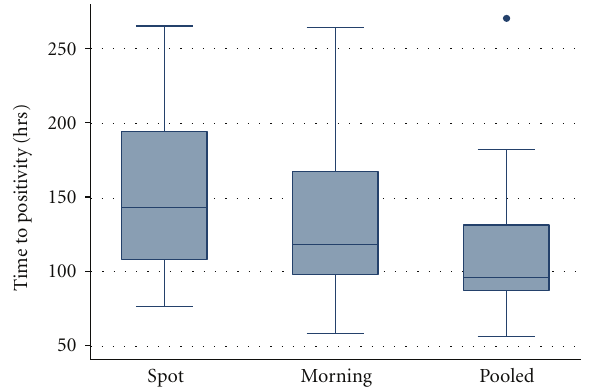
Figure 2: Median time-to-culture positivity among di ff erent collec- tion method. ∗ P < 0 . 005 comparing pooled to morning or